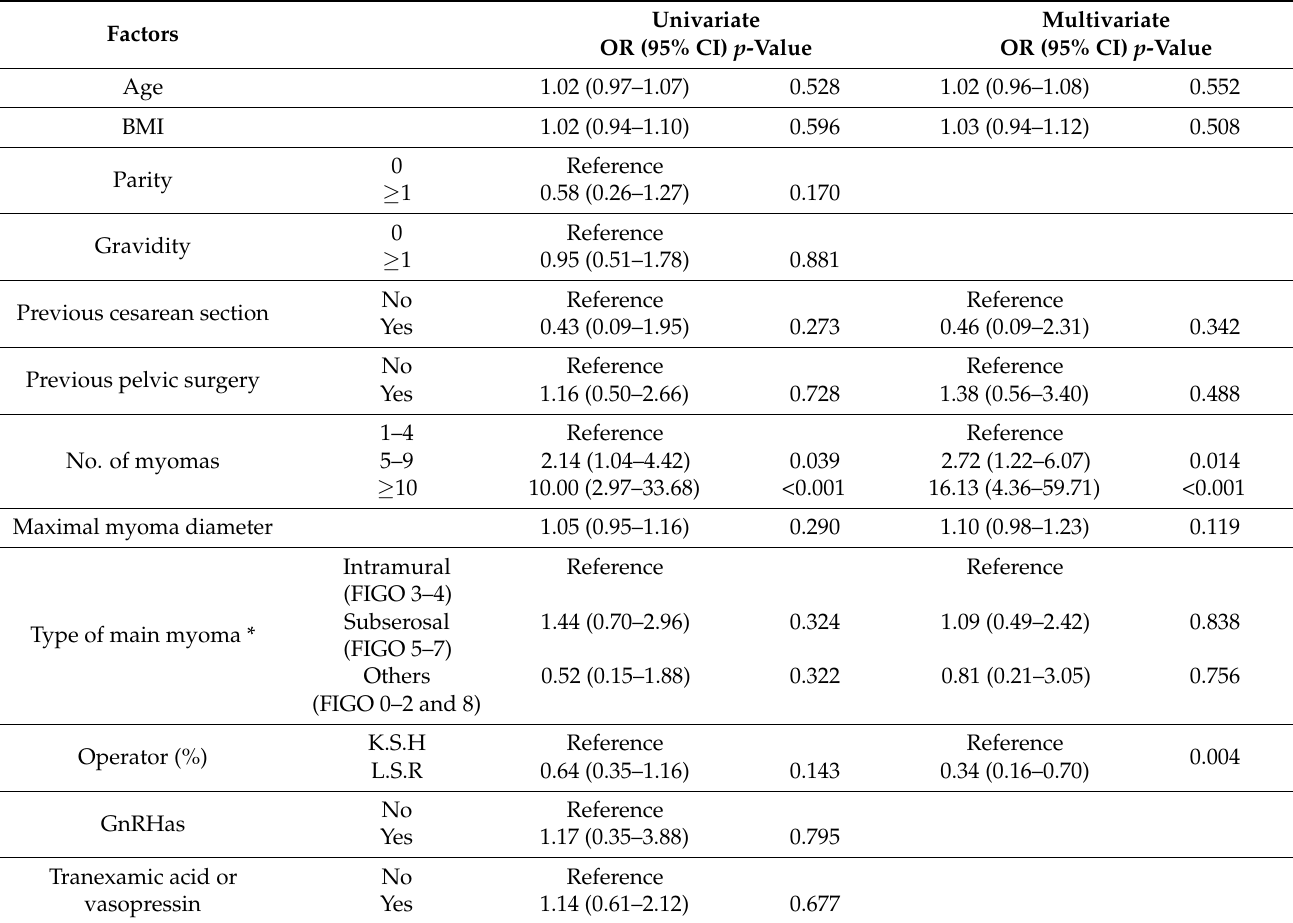
Table 3. Univariate and multivariate logistic regression analyses of operation time > 3